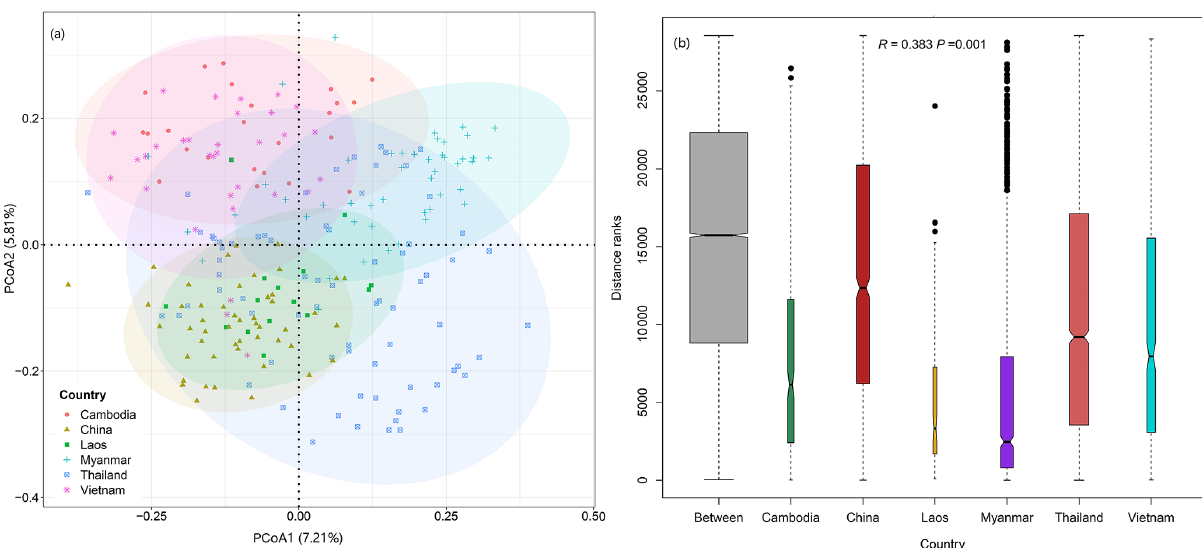
Figure 3. Significant difference in plant community compositions of rubber plantations among countries in the GMS. (a) Principal coordinate analysis (PCoA) based on Bray–Curtis distance; (b) analysis of similarity among countries.